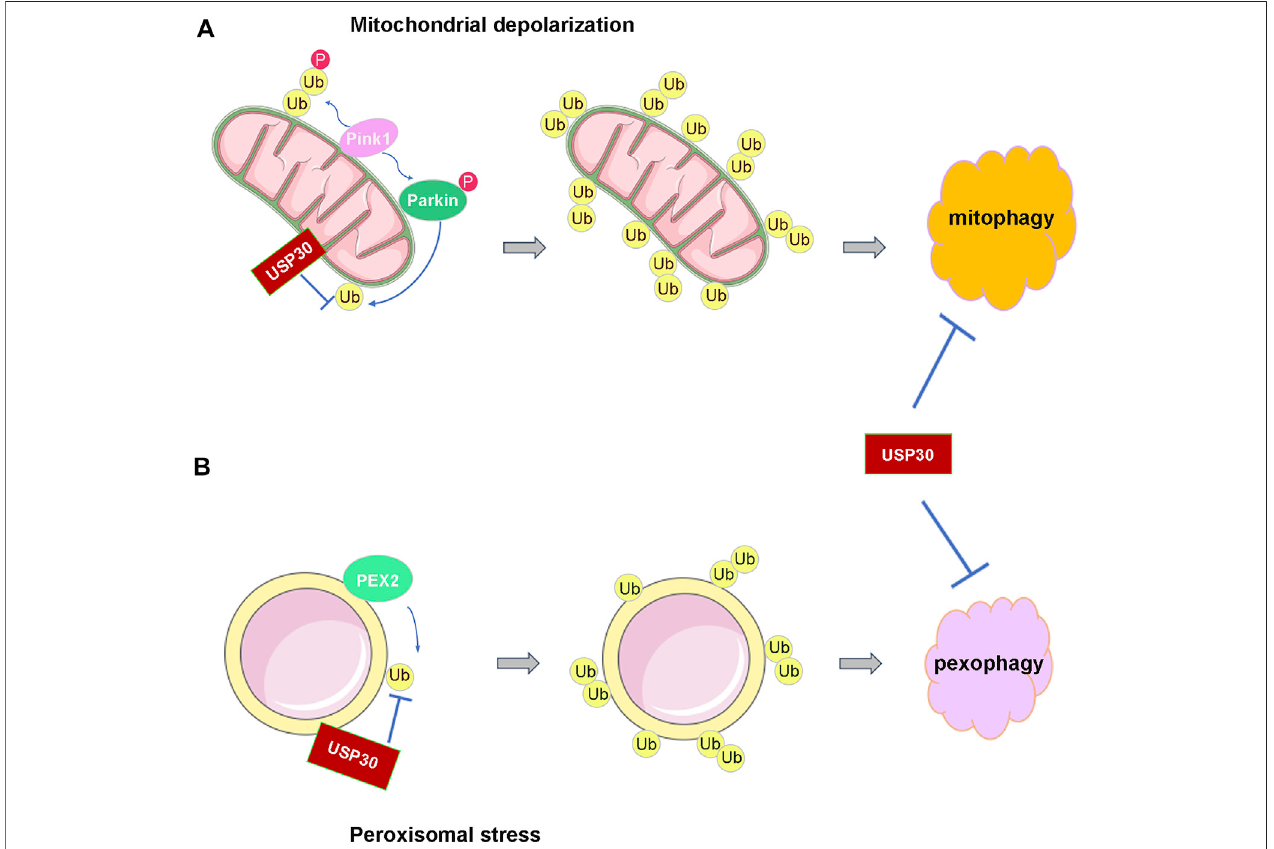
FIGURE2| USP30antagonizestheubiquitinationprocessofmitochondriaandperoxisometopreventtheirautophagy. (A) USP30preventstheactivationofParkin and the ubiquitination of mitochondria and then antagonizes mitophagy under the depolarization condition. (B) USP30 also limits the pexophagy through reversing the ubiquitination of peroxisome by PEX2.